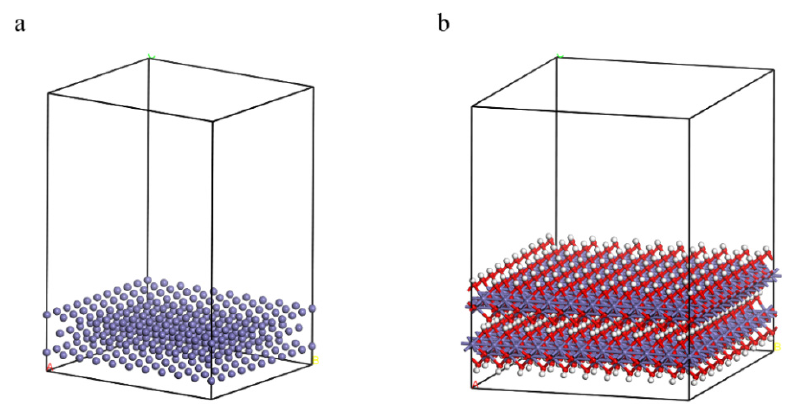
Figure 2. Interface models: ( a ) Fe and ( b ) γ -FeOOH.